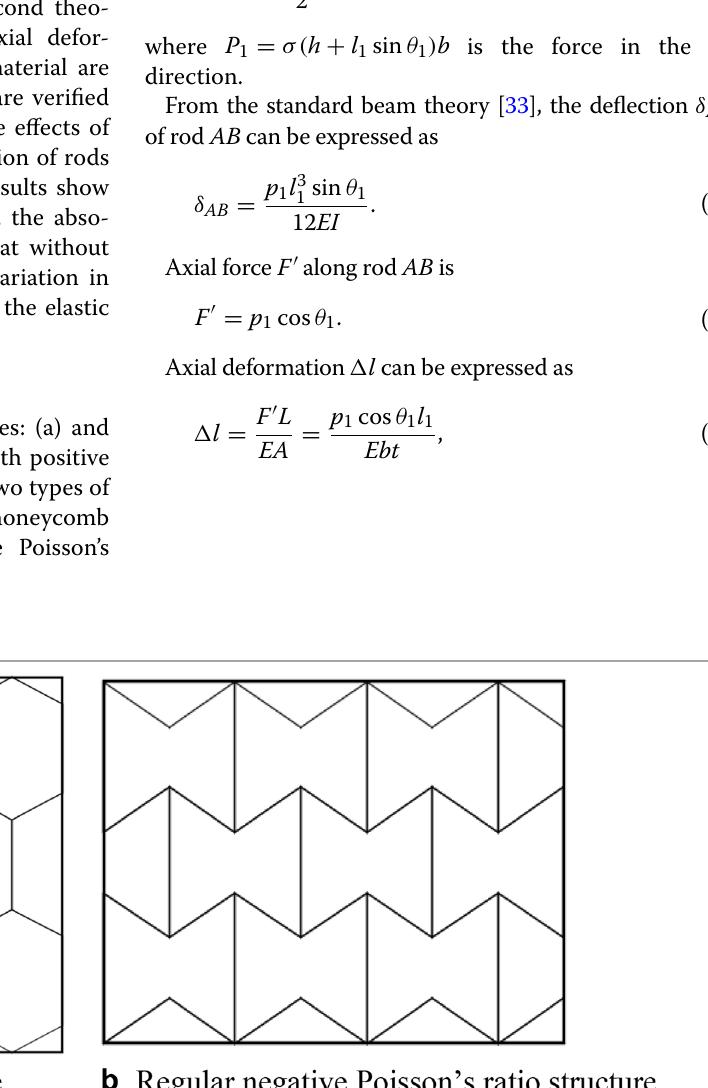
Figure 1 Regular